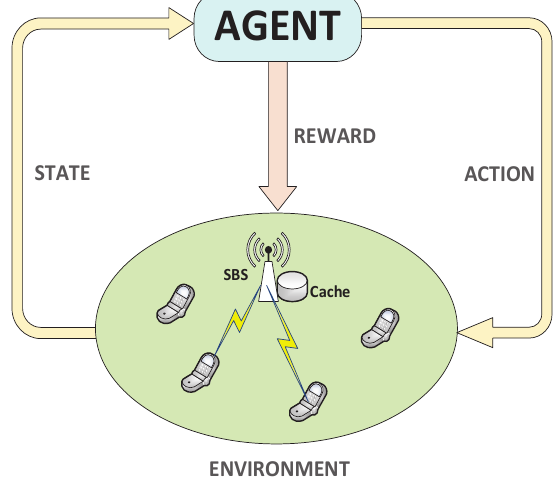
Figure 2. An illustration of RL based data caching in wireless